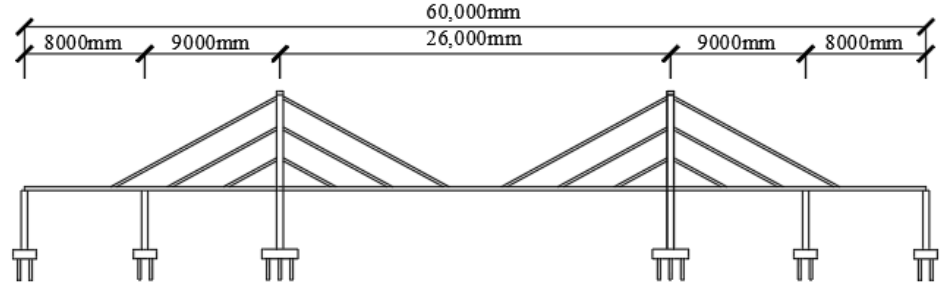
Figure 4. The general arrangement of the main bridge.